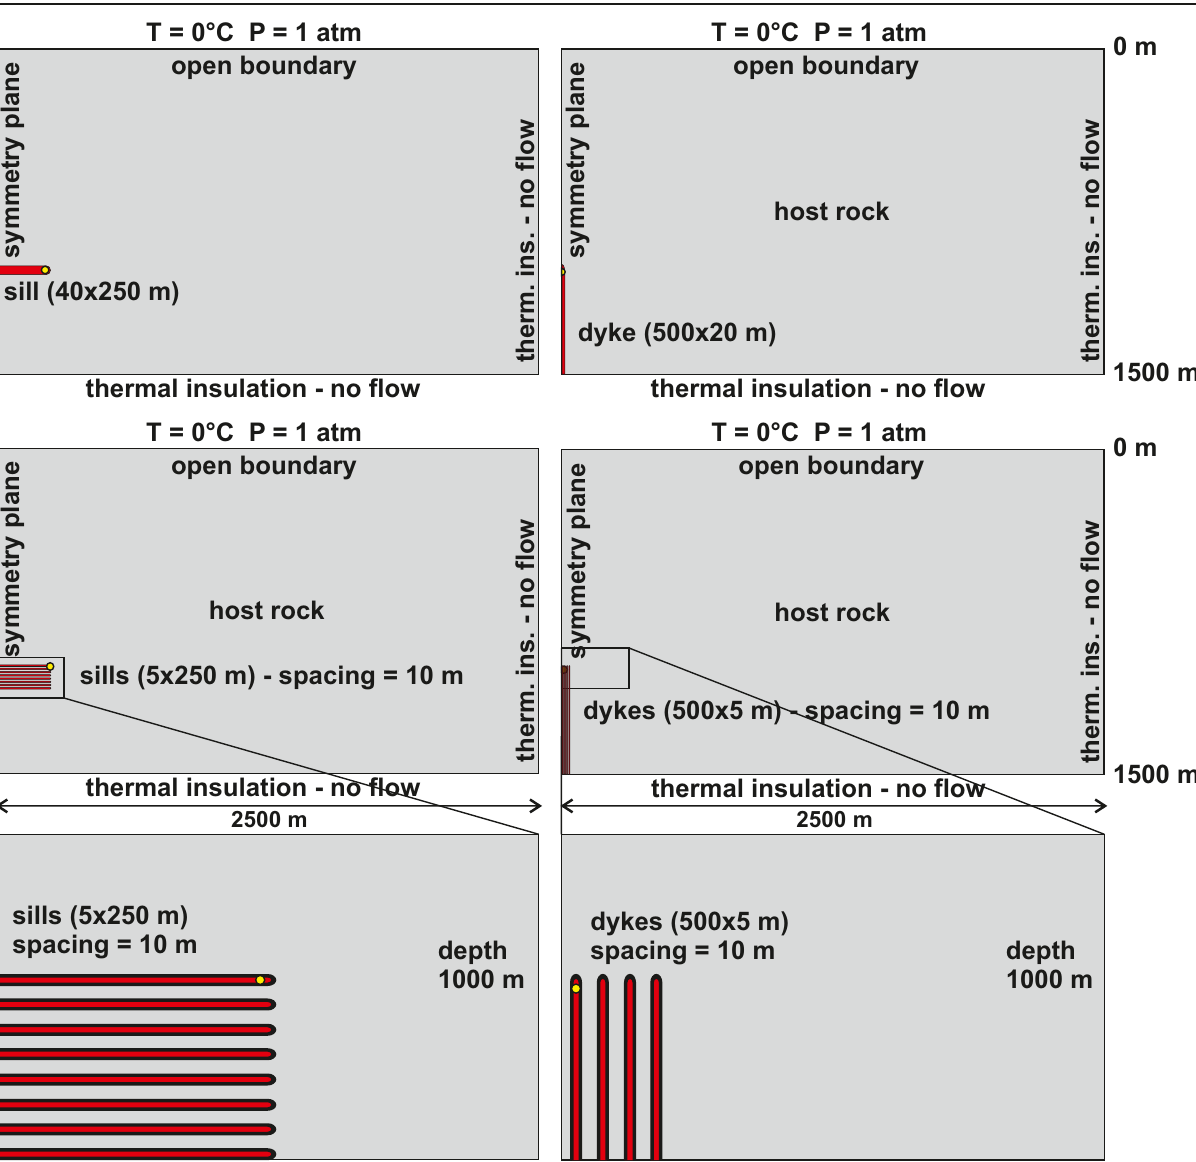
Figure 7: Sketches of the model geometries with intrusions in red and host-rock in grey. Yellow circles mark the locations of temperature measurements in Figure 10. Note that the drawings are not exactly to scale to allow visibility of small features. 1 atm = 101,325